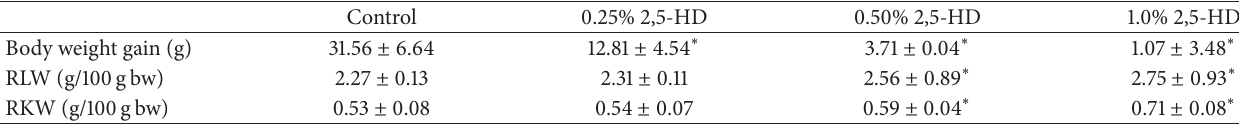
Table 1: Body weights and organ weights of rats exposed to 2,5-hexanedione for 21 days.